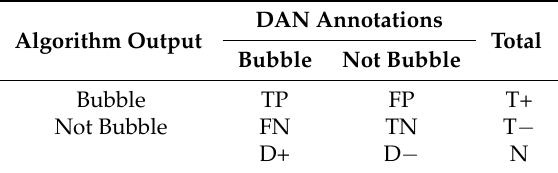
Table 2. Performing sensitivity and specificity. Algorithm